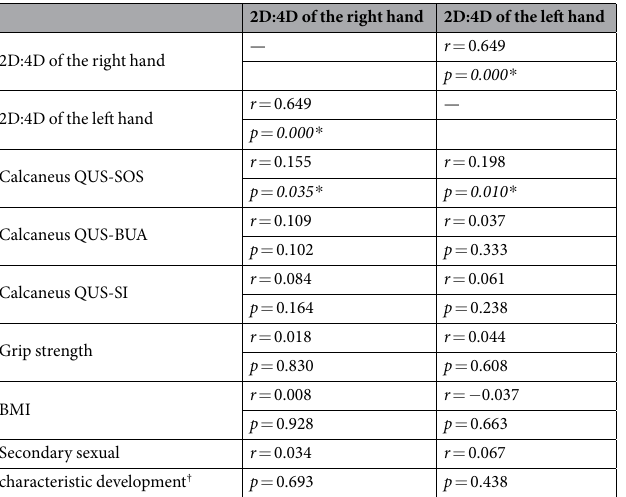
Table 2. The effect of the digit ratio (2D:4D) of both hands on the calcaneus QUS values with Pearson’s correlation coefficient, n = 138. 2D:4D, ratio of the finger length of the 2 nd and 4 th digit; QUS-SI, stiffness index by quantitative ultrasound; QUS-SOS, speed of sound by quantitative ultrasound; QUS-BUA, broadband ultrasound attenuation by quantitative ultrasound; BMI, body mass index. † The age at which menstruation started. * Indicates a significant correlation with calcaneus